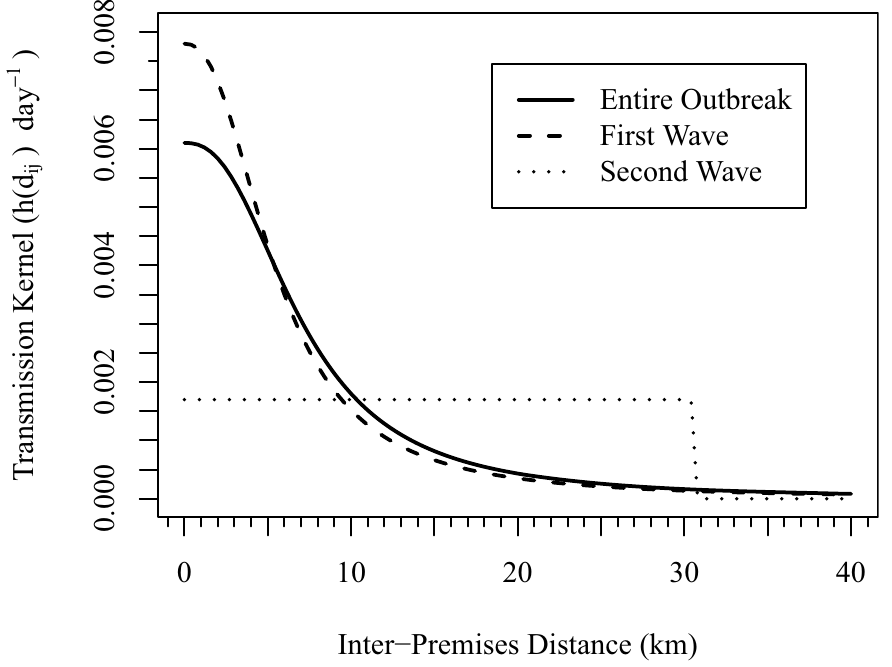
Fig 3. Minnesota spatial transmission kernels. Spatial transmission kernels estimated from the three different outbreak periods evaluated across distance using the mean parameter estimates under the baseline scenario given